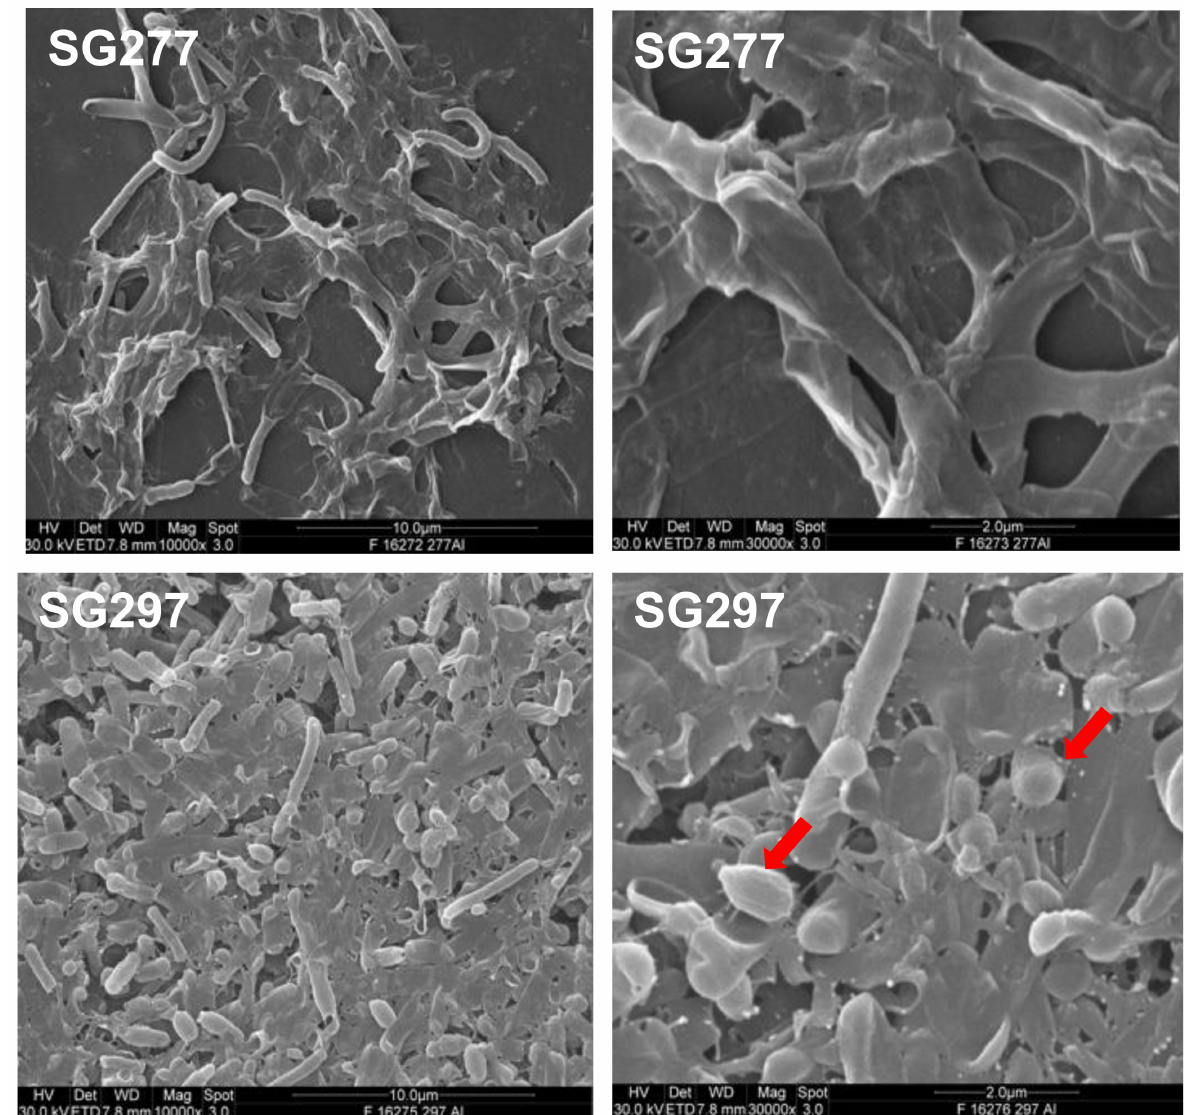
Figure 5. SG277 and SG297 biofilms. Biofilms developed in S7 medium and imaged using SEM. Red arrows highlight spores in the